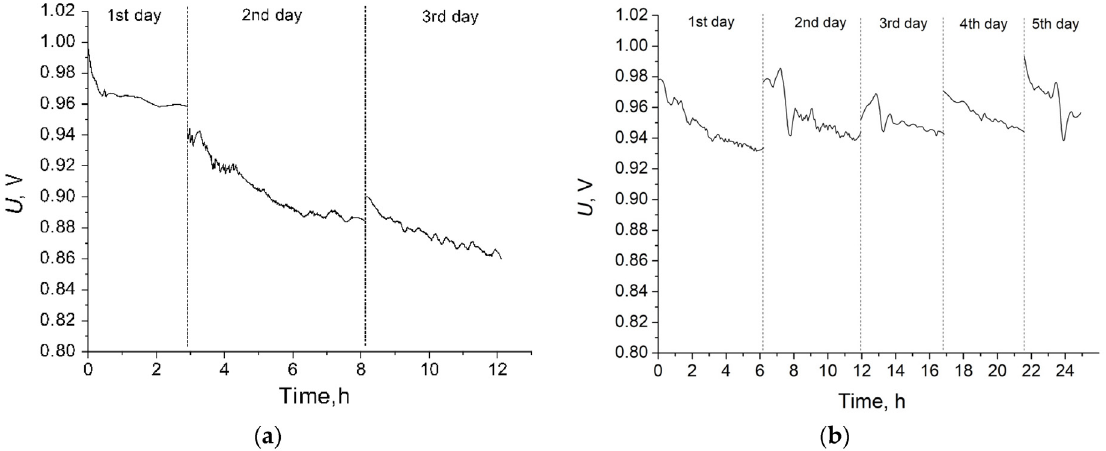
Figure 7. Open-circuit voltage changes in the MEAs with MCG-0 membrane ( a ) for three days and with the MCG-3 membrane ( b ) for five days. The cell temperature is 90 ◦ C and the gas RH is